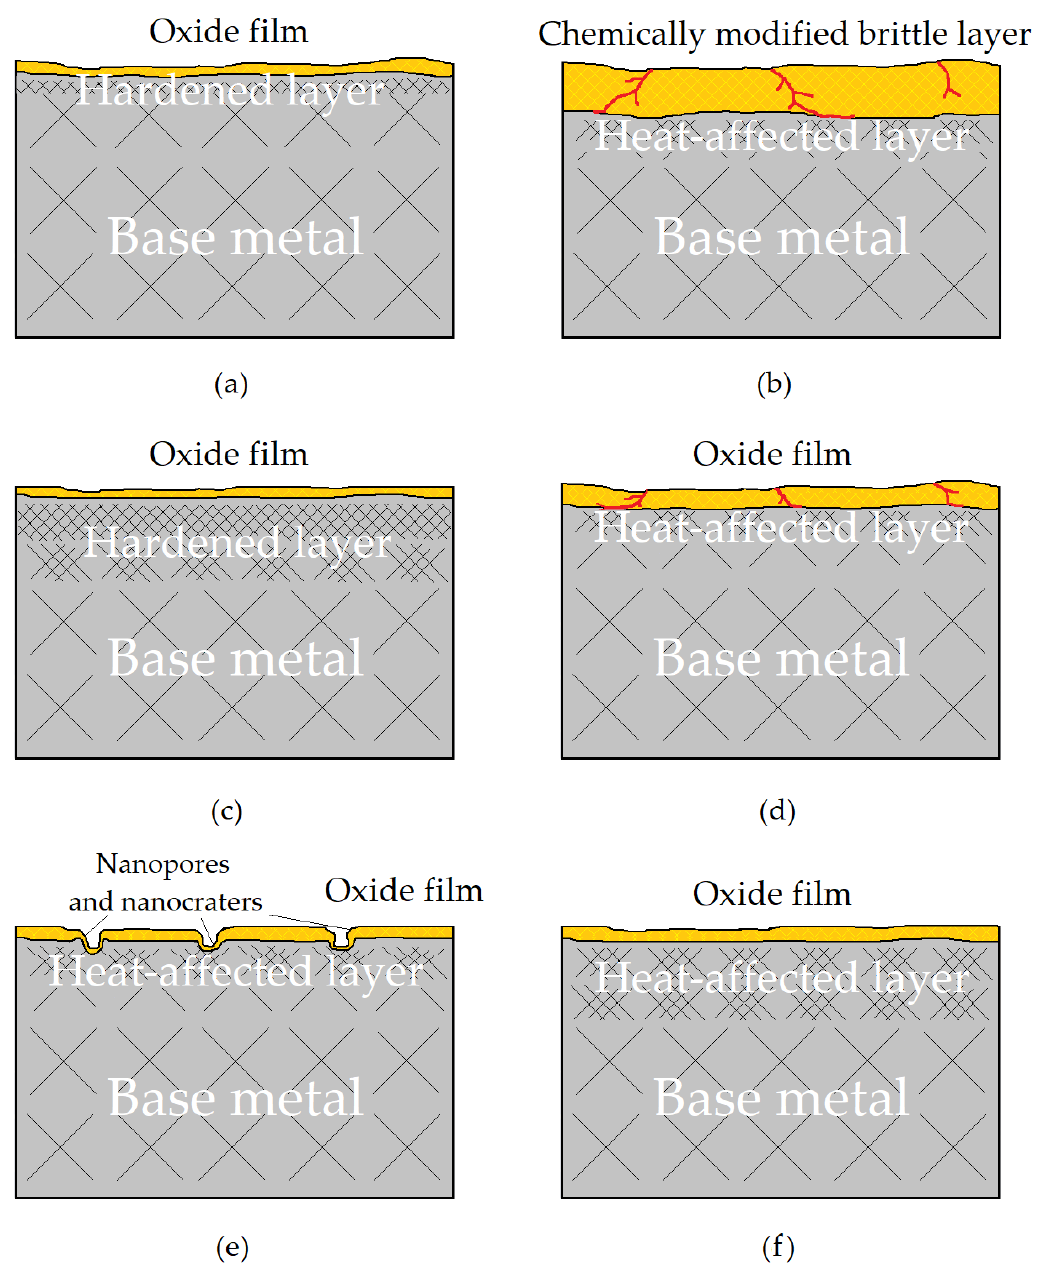
Figure 10. Scheme of surface layers after various types of post-processing: ( a ) mechanical machining; ( b ) chemical etching; ( c ) surface plastic deformation; ( d ) cavitation abrasive finishing; ( e ) laser ablation [133]; ( f ) ion polishing in gas-discharge plasma, where heat-affected layer includes dislocation area, area of increased dislocation density with Cottrell zones (negatively charged acceptors).